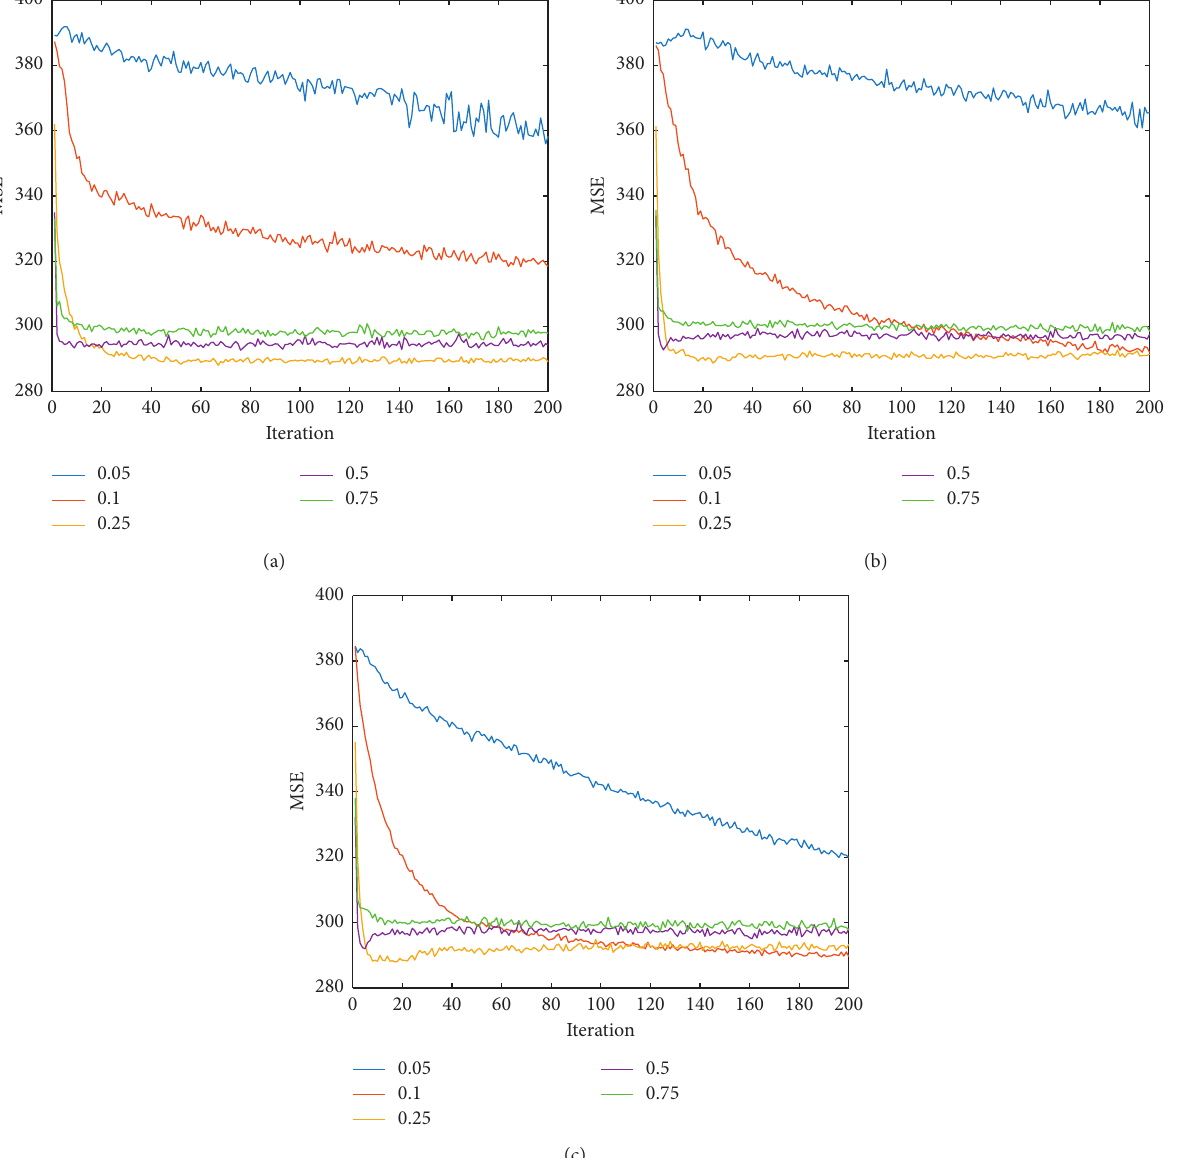
Figure 11: Evolution of the MSE for different values of σ and number of neurons M . (a) Influence of σ in MSE evolution, M � 9. (b) Influence of σ in MSE evolution, M � 25. (c) Influence of σ in MSE evolution, M �